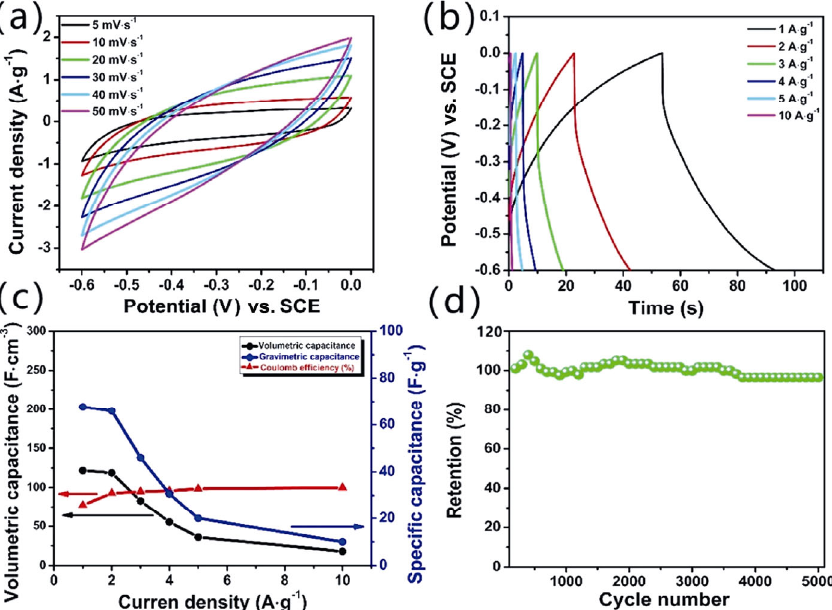
Fig. 23 (a) CV curves at various scan rates, (b) galvanostatic charge/discharge curves at different current densities, (c) specific capacitance and coulombic efficiency at various current densities, and (d) cycling performance of the Ti 3 C 2 electrode at a current density of 10 A·g − 1 . Reproduced with permission from Ref. [225], © Royal Society of Chemistry